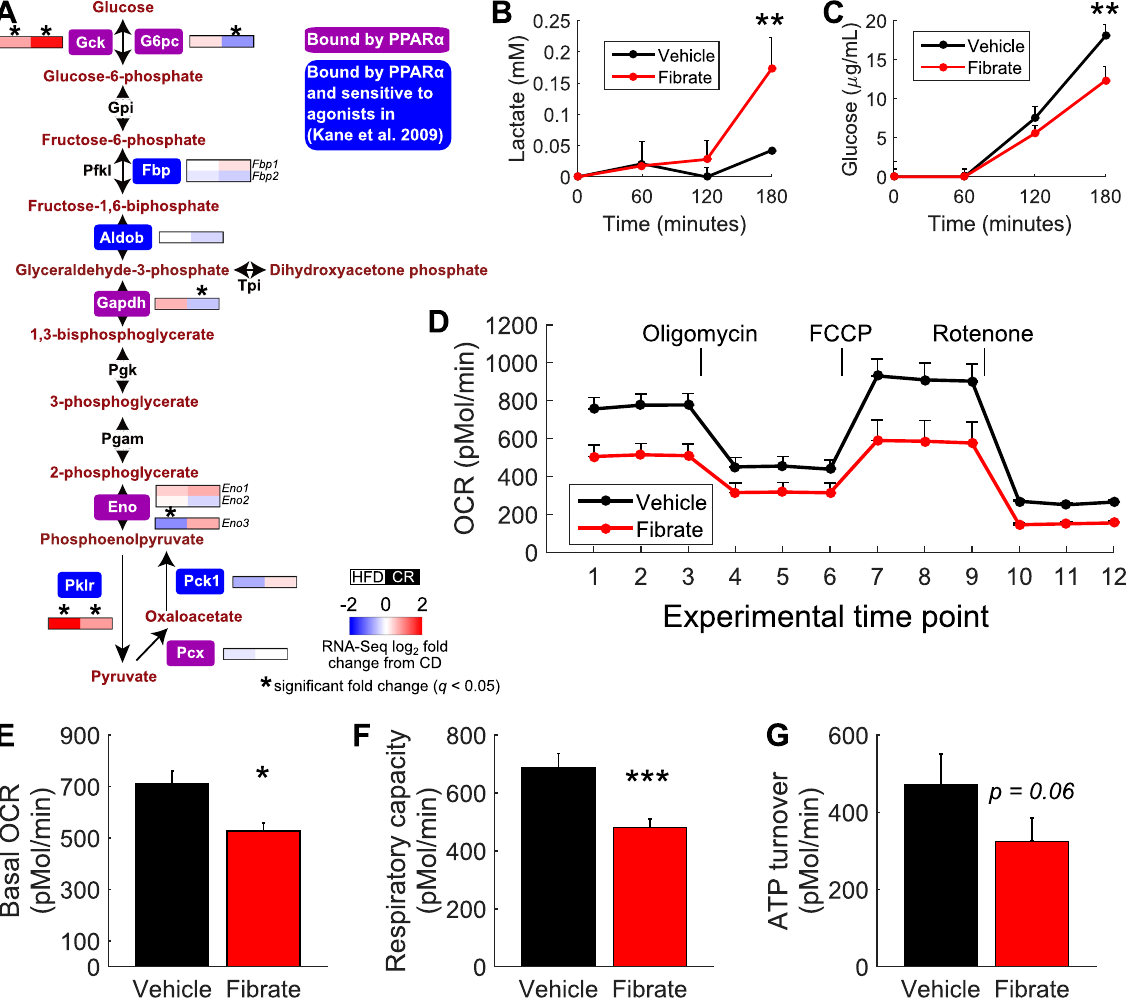
Figure 4. PPAR α binds extensively near genes involved in gluconeogenesis/glycolysis in CR and HFD livers and activation by fenofibrate enhances anaerobic glycolysis in primary hepatocytes. ( A ) Canonical gluconeogenesis/glycolysis pathway highlighting genes bound by PPAR α (purple outline boxes) and genes both bound by PPAR α in our dataset and sensitive to fibrate in Kane et al . 20 (blue outline boxes). The two- element color bars near the bound genes represent the log 2 fold-changes in mRNA expression (by RNA-Seq) for these genes in HFD and CR livers, respectively, versus CD. * Indicates statistically significant changes ( q < 0.05). ( B ) Lactate production in mouse primary hepatocytes following vehicle (black line) or fenofibrate (red line) treatment in the presence of glucose. ( C ) Glucose production in the presence of lactate/pyruvate as a gluconeogenic source following vehicle (black line) or fenofibrate (red line) treatment. ( D ) Oxygen consumption rate (OCR) assessed in the presence of glucose following vehicle (black line) or fenofibrate (red line) treatment. OCR also assessed following oligomycin, FCCP, and rotenone drug treatments. ( E–G ) Assessment of basal OCR ( E ), respiratory capacity ( F ), and ATP turnover ( G ) in primary hepatocytes following vehicle or fenofibrate